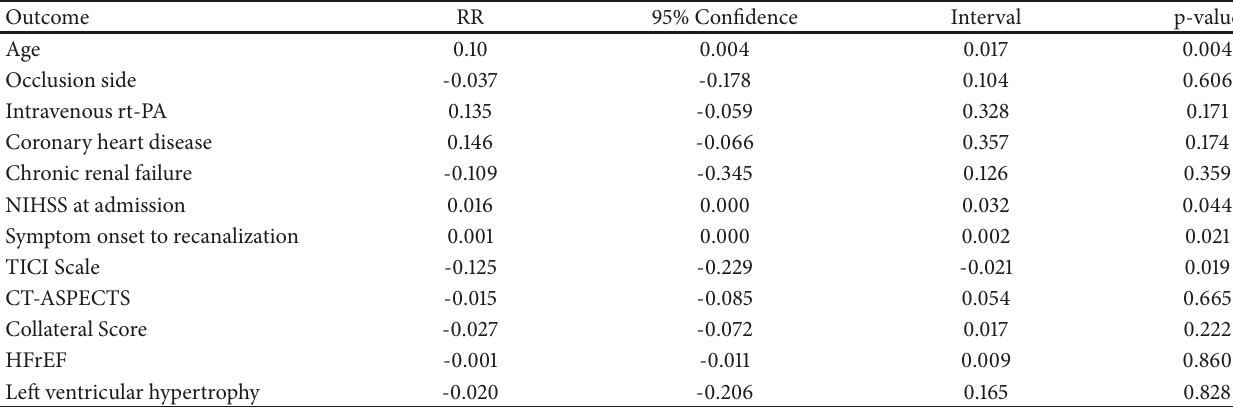
Table 4: Regression analysis regarding predictors of a good outcome (mRS 0-2) in patients with mechanical thrombectomy in LVO. Outcome